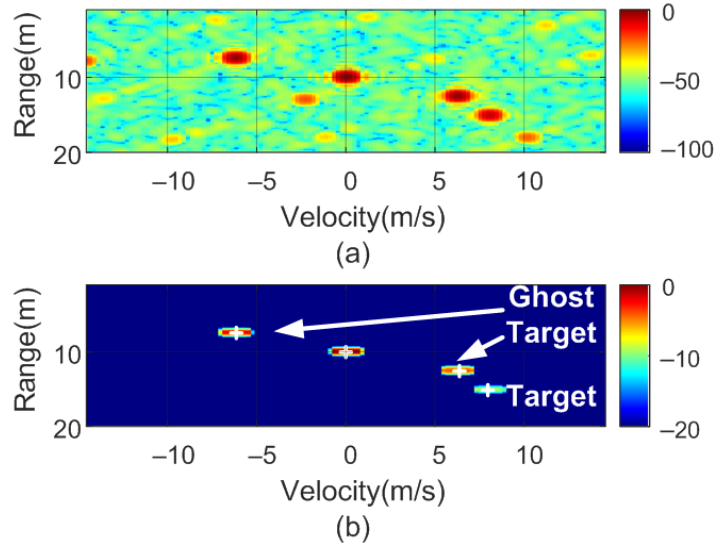
Figure 25. Simulated range–Doppler map ( a ) and after CFAR detector ( b ) with a real target at 15 m and 8 m/s with the slope